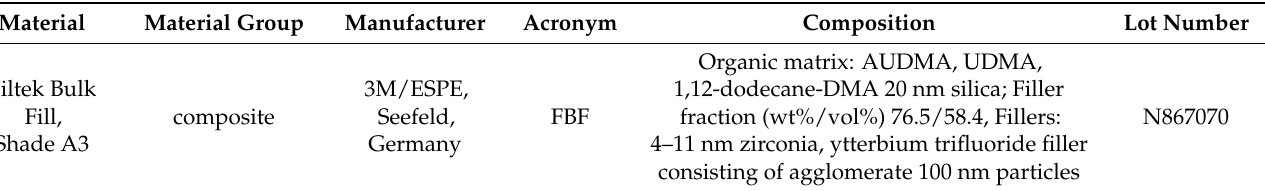
Table 1. Detailed characteristics of the dental restorative materials used in the